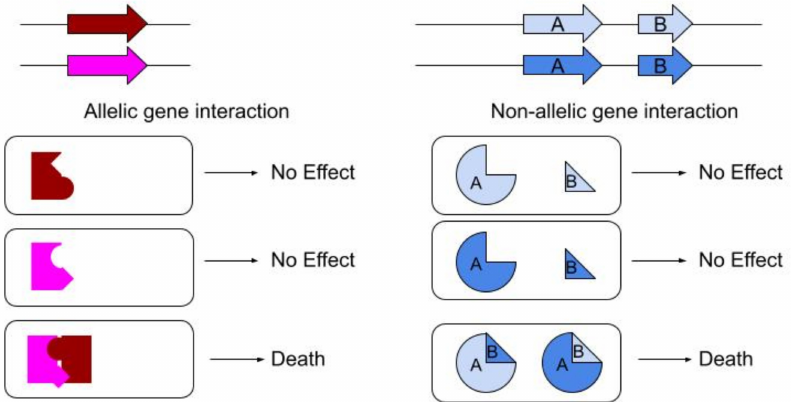
Figure 1. Traditional models for gene interactions leading to cell death from nonself recognition in ascomycete systems. The interactions can be based on direct gene product interactions, whether allelic (alleles of the same gene), or non-allelic (with alternate alleles of genetically linked genes). These systems act similarly upon fusion, but non-allelic systems differ during reproduction, where self- incompatible offspring result from the interaction produced from recombination between genes in a nonallelic locus. Note that non-allelic interactions are often asymmetric (e.g., only the combination of light blue A and dark blue B may be toxic, the interaction of dark blue A and light blue B may have no